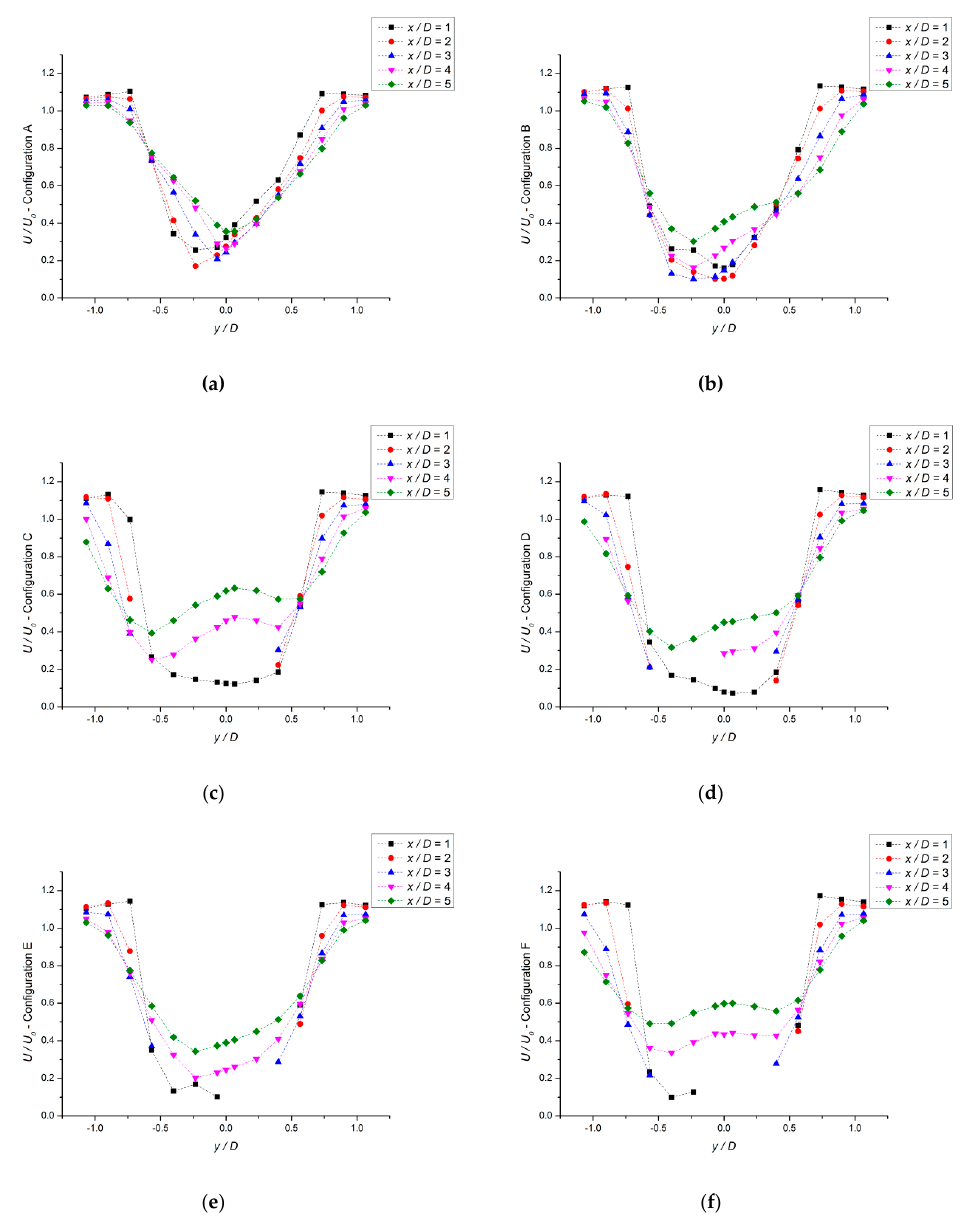
Figure 4. The wake profiles in different configurations. The wake profiles for ( a ) configuration A, ( b ) configuration B, ( c ) configuration C, ( d ) configuration D, ( e ) configuration e, ( f ) configuration